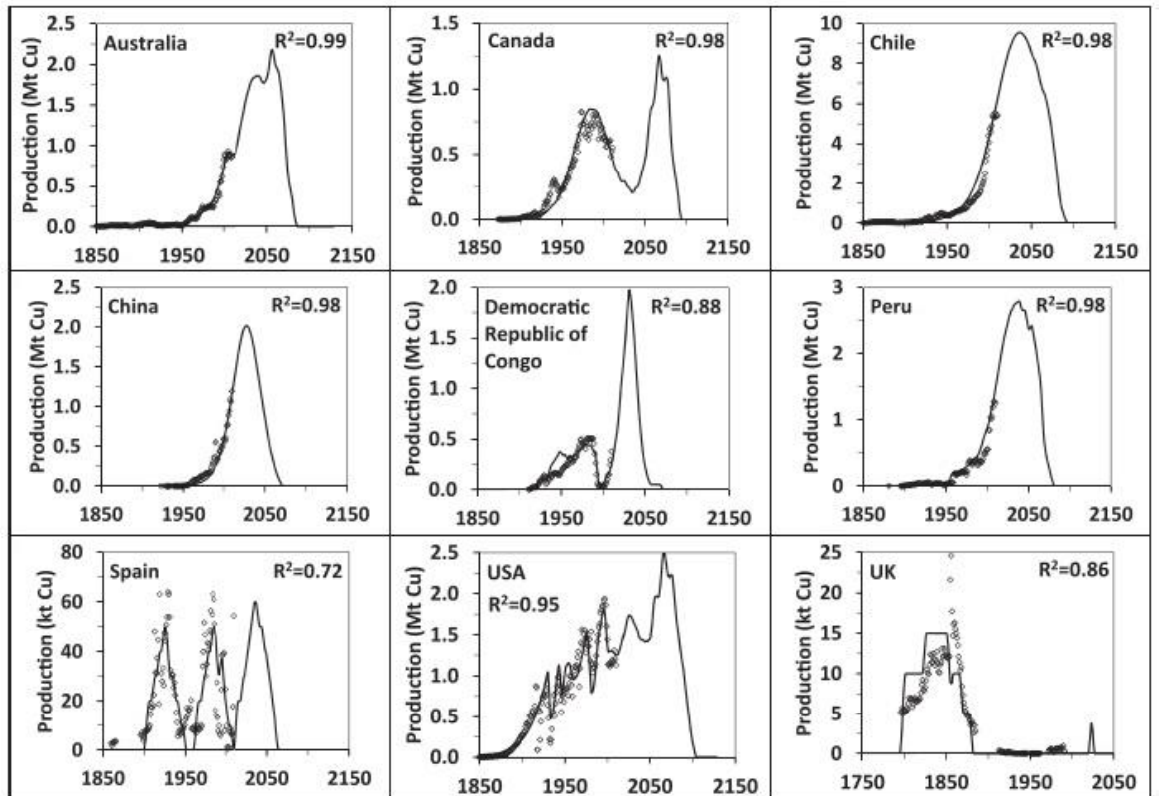
Figure 4. Historic copper production data (symbols) and modelled (line) scenarios for selected countries [45].